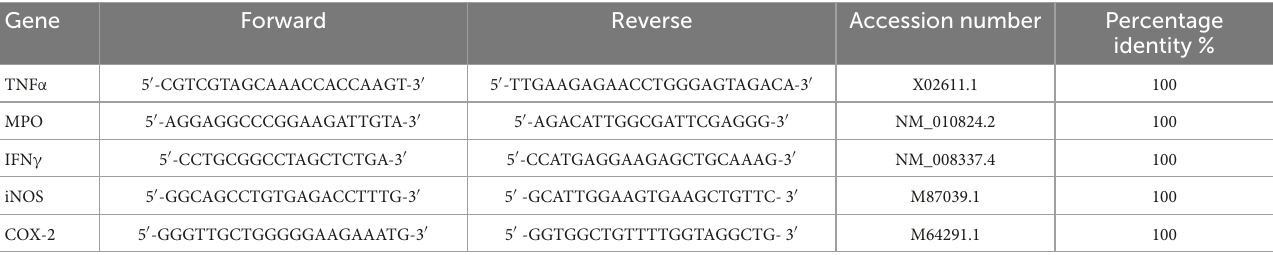
TABLE 2 Primer sequences used for real-time